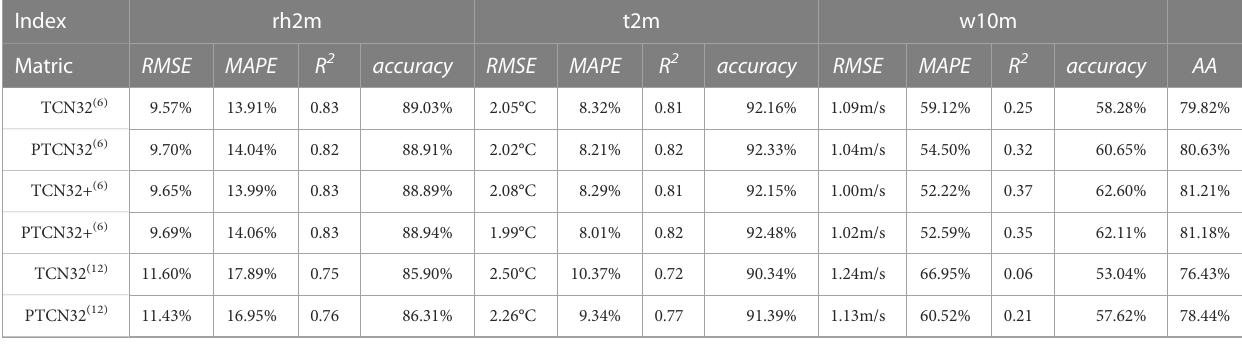
TABLE 5 Ablation